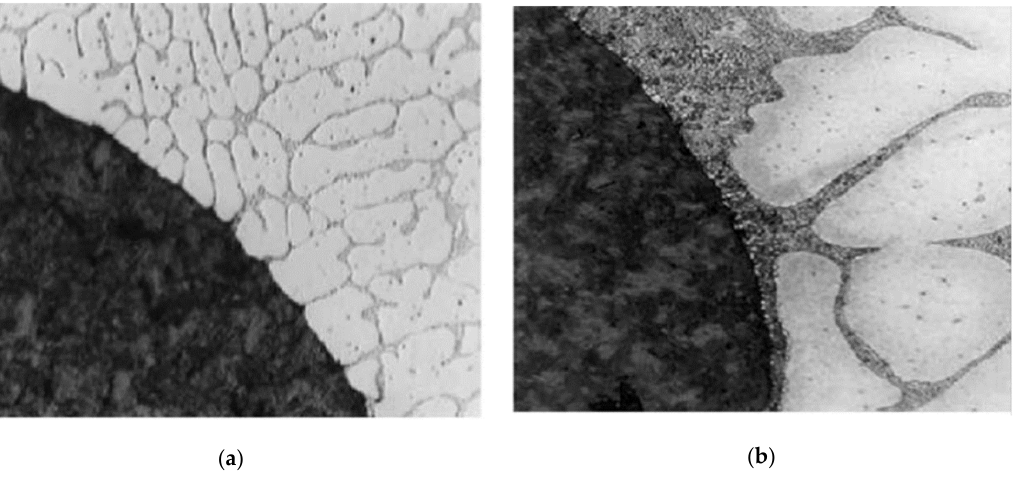
Figure 20. Solidifying microstructure of thermally managed Al-9% Cu alloy composite ( a ) with external cooling of graphite rod extending out of the melt and ( b ) without external cooling of the graphite rod [27].